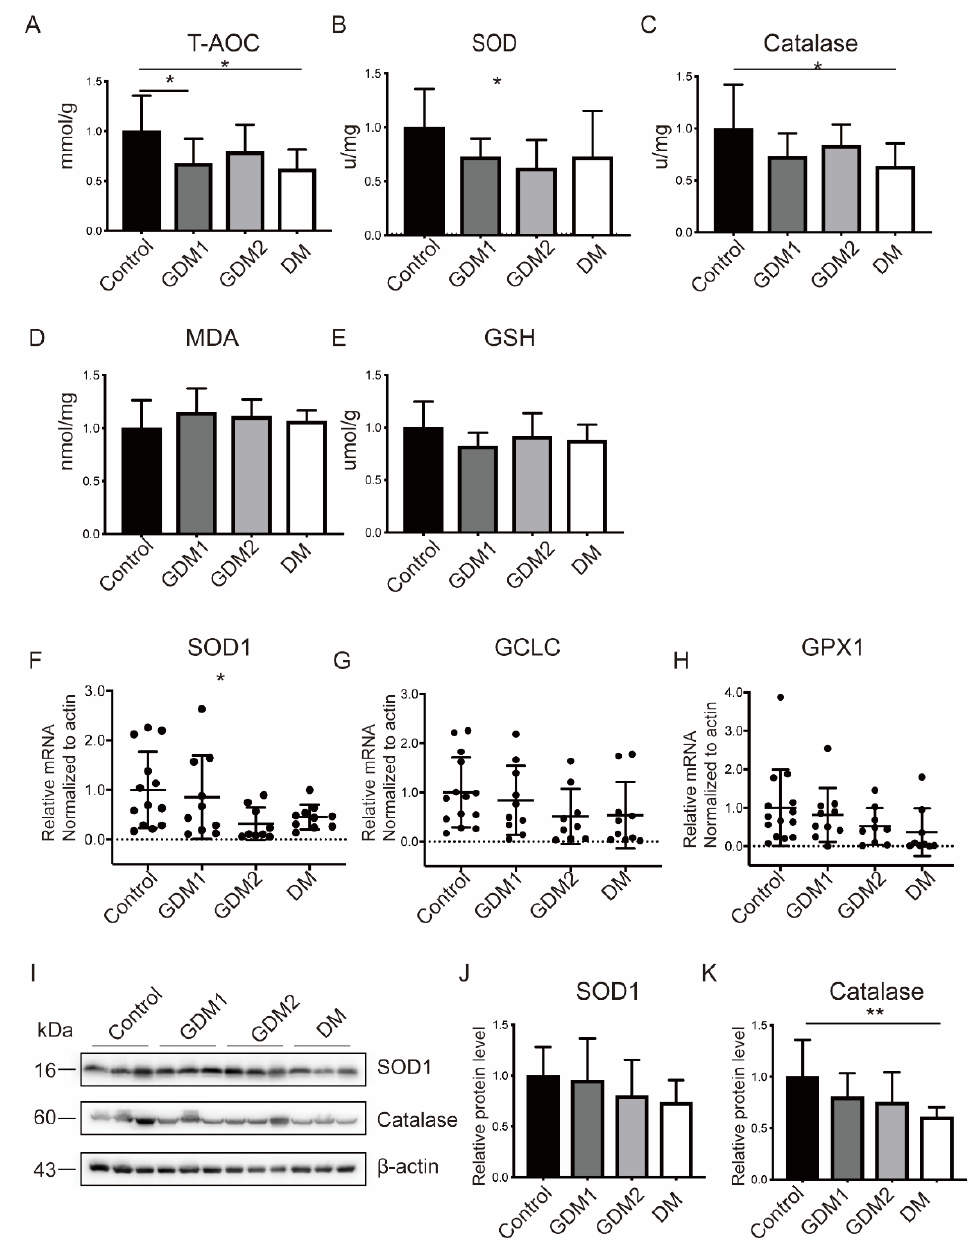
Figure 1. The balance between oxidant and antioxidant substances was disturbed in HIP pregnancies. ( A – E ) Changes in the capacity and activity of oxidative stress-related molecules. ( F – K ) Placental mRNA and protein levels of antioxidant molecules. Actin served as the internal controls. Data are the mean ± SEM. * p < 0.05 and ** p < 0.01 by a one-way ANOVA test, followed by a post hoc test.